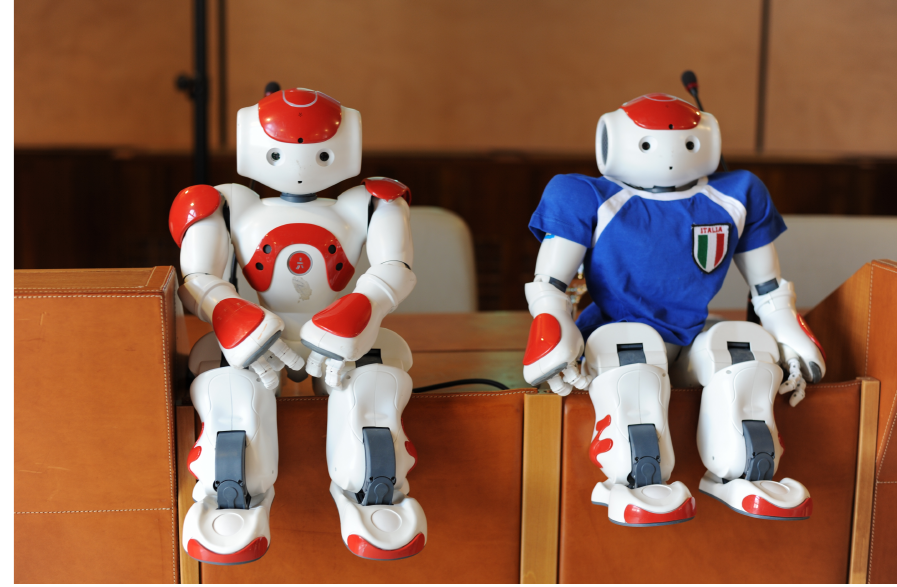
Figure 1. The two NAOs of the